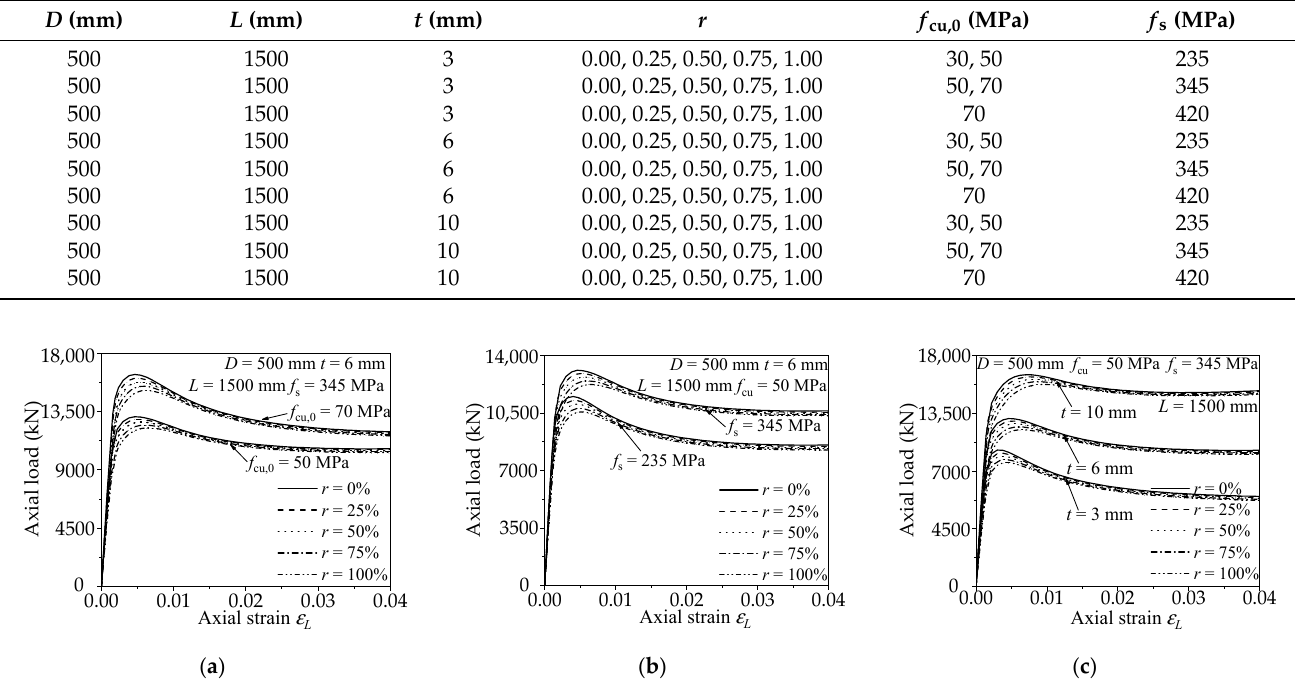
Figure 6. Influence of various parameters: ( a ) concrete strength; ( b ) steel strength; ( c ) steel ratio.